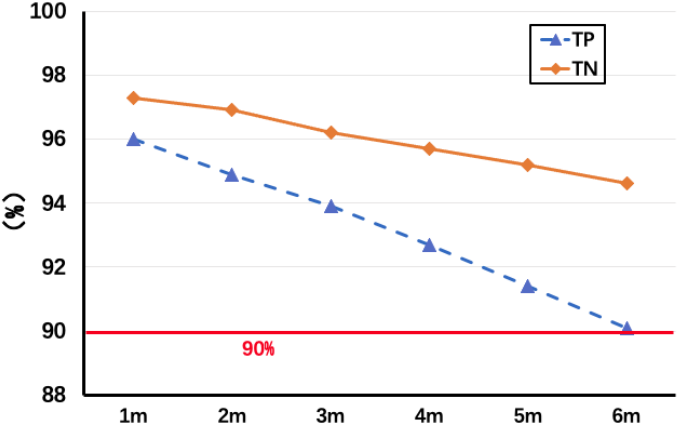
Figure 12. Change of TP/TN with distance between